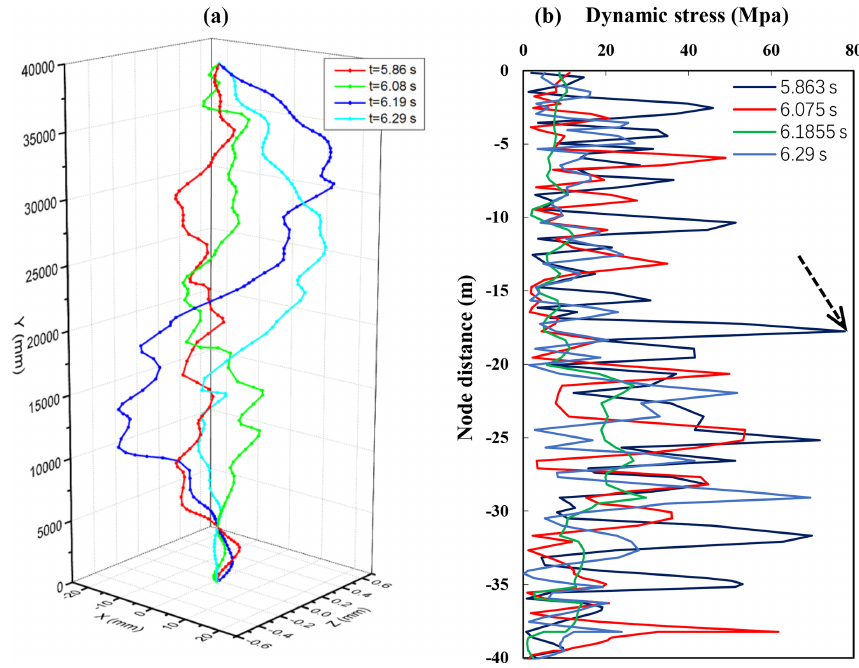
Figure 7. The variation of the displacement and the stress of each node in the drill assembly with time.